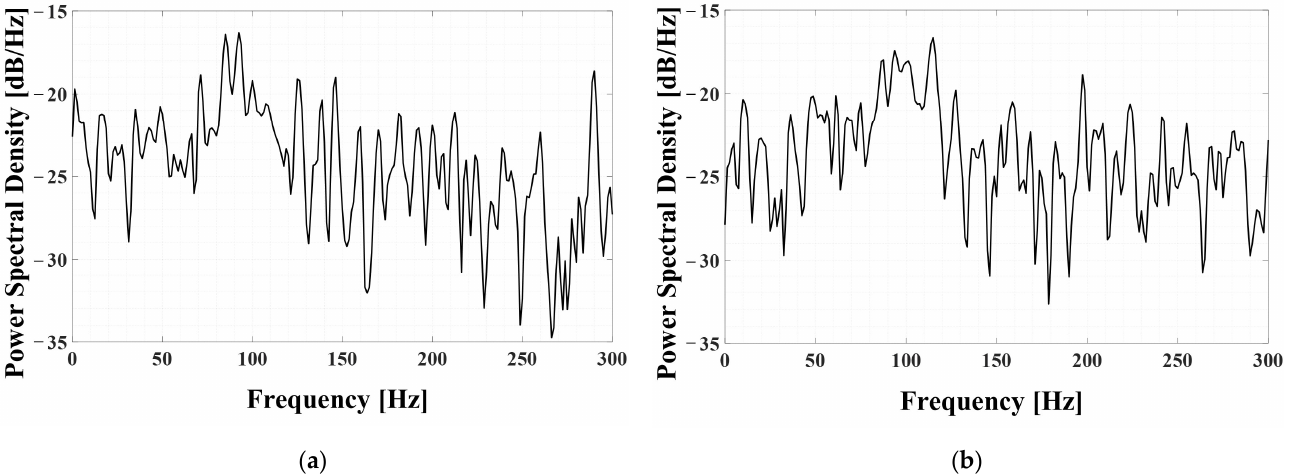
Figure 5. Frequency response calculated by the virtual measurement signal: ( a ) frequency response calculated by virtual measurement signal x(t) and ( b ) frequency response calculated by virtual measurement signal y(t).